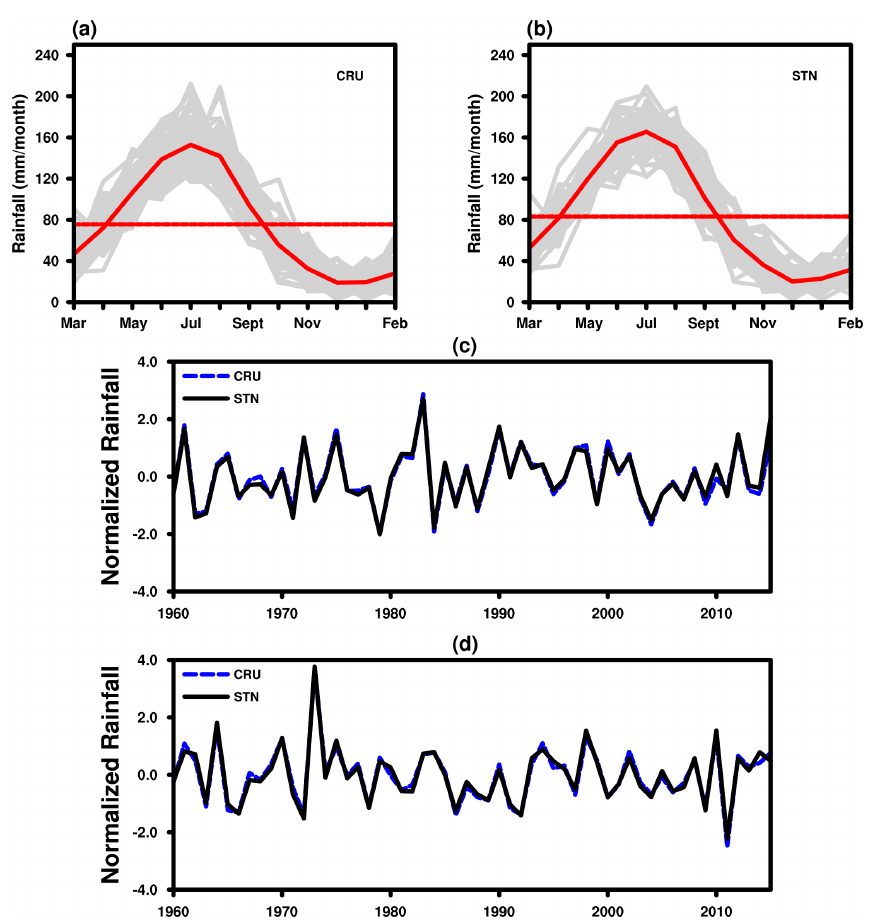
Figure 1. Annual rainfall at all stations (STN) and grid (CRU) points shown as gray lines and their mean in a solid red line: (a) observation and (b) CRU. Seasonal mean precipitation anomalies from observation (black) and CRU (blue) for (c) the dry season and (d) the wet